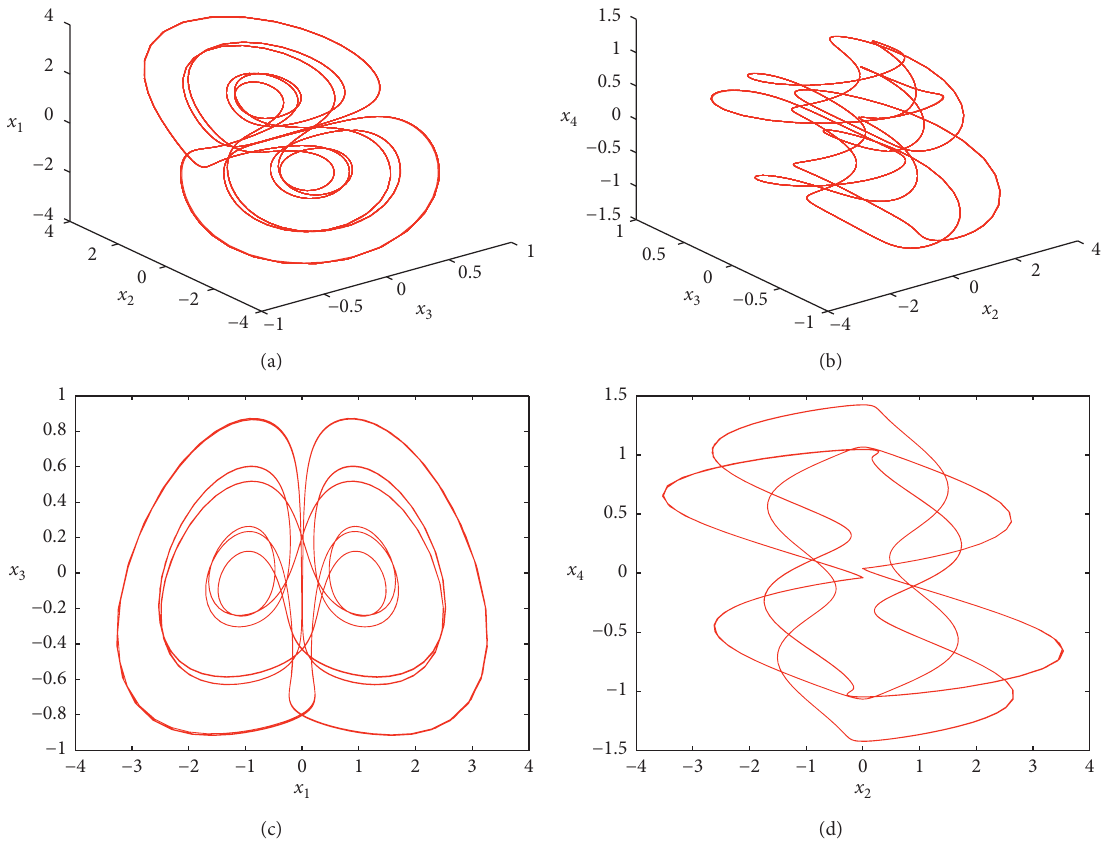
Figure 4: Periodic motion of system (2) with a � 20, b � c � 1, and k � 12: (a) x